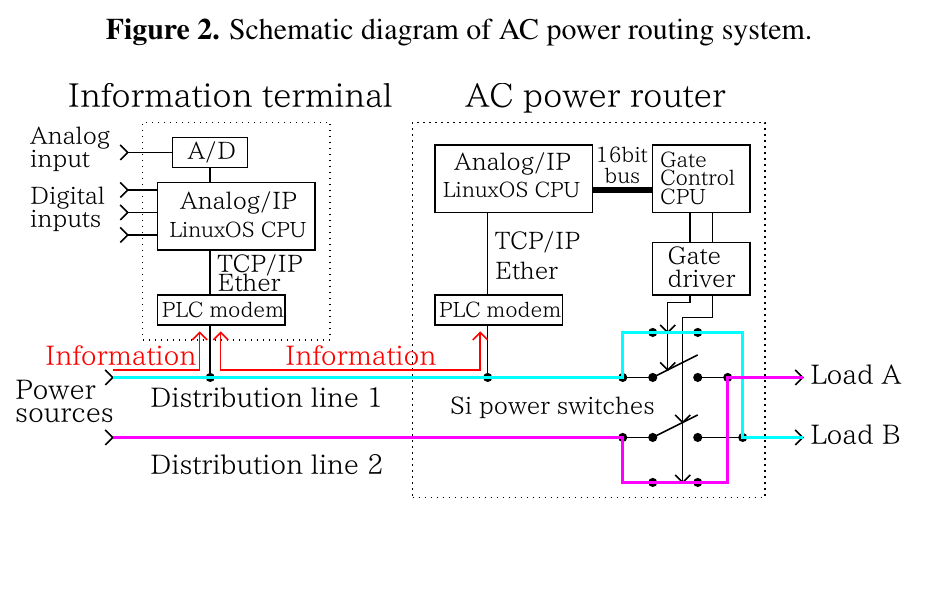
Figure 3. Photograph of a prototype AC power router and information